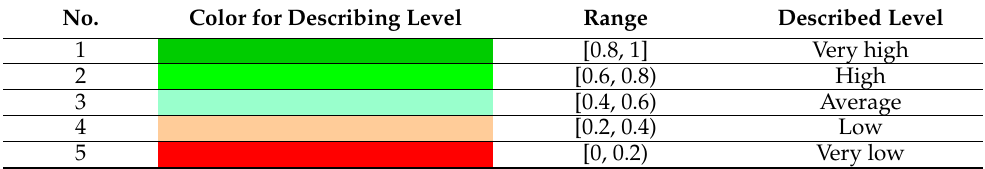
Table 2. Color coding for overall levels of each